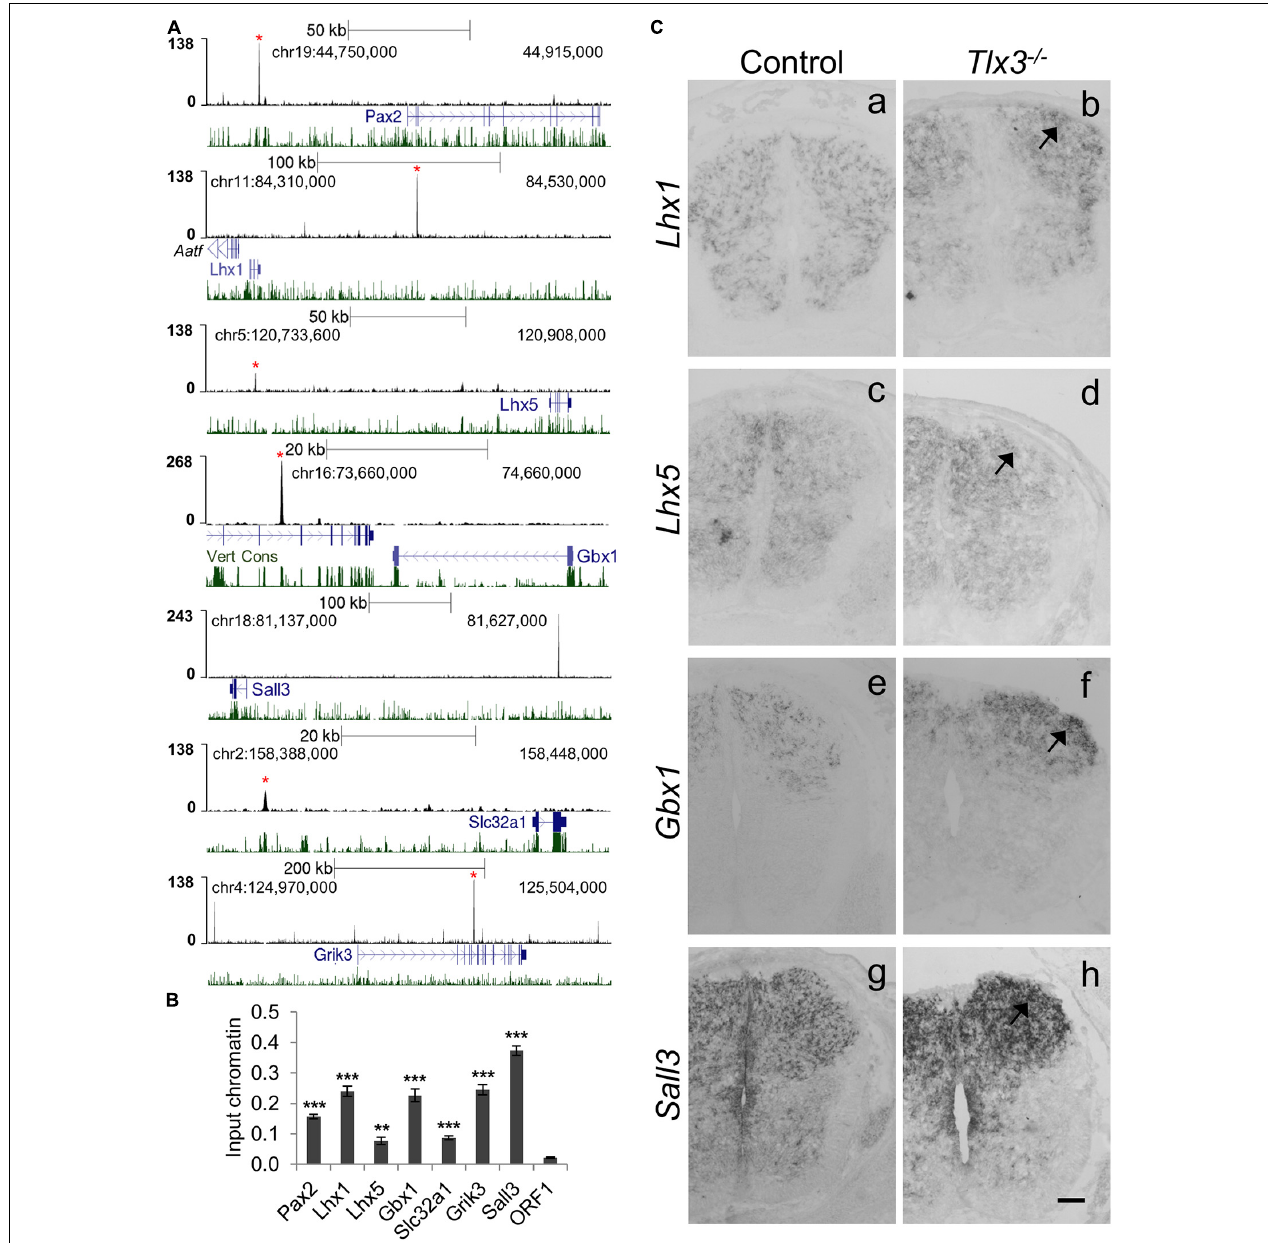
FIGURE 4 | Tlx3 directly controls the expression of transcription factors and terminal differentiation genes involved in GABAergic differentiation. (A) Tlx3 binding profile (black) within genomic regions spanning target genes. Target gene structure and direction of transcription (blue) as well as multispecies vertebrate conservation plots (green) are shown. Binding sites validated by ChIP-qPCR are marked by red asterisks. (B) Validation of Tlx3 binding sites by independent ChIP-qPCR using chromatin extracted from E14.5 dorsal spinal cords. Negative control region (ORF1) is shown. Mean ± SD; ** P < 0.01 and *** P < 0.001 as compared to ORF1 with Student’s t -test; n = 3 experimental replicates. (C) Derepression of GABAergic markers in Tlx3 null dorsal spinal cord assessed by in situ hybridization. a–h Transverse sections through the lumbar spinal cord of E14.5 wild type [a ( n = 6); c ( n = 6); e ( n = 7); g ( n = 3)] and Tlx3 null mutants [b ( n = 4); d ( n = 3); f ( n = 3); h ( n = 3)]. Lhx1 , Lhx5 , Gbx1 , and Sall3 expression in the dorsal horn was markedly increased (b, d, f, h, arrow) in Tlx3 mutants as compared to controls. Scale bar: 100 µ